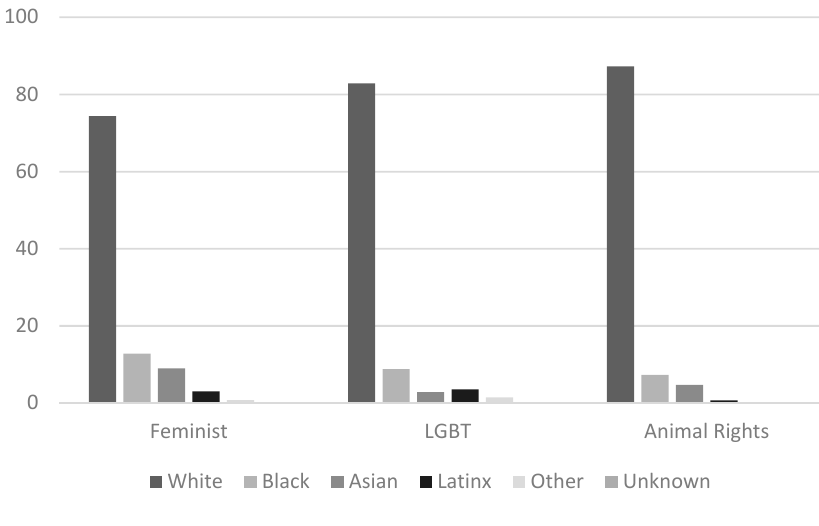
Figure 2. Distribution of Race.